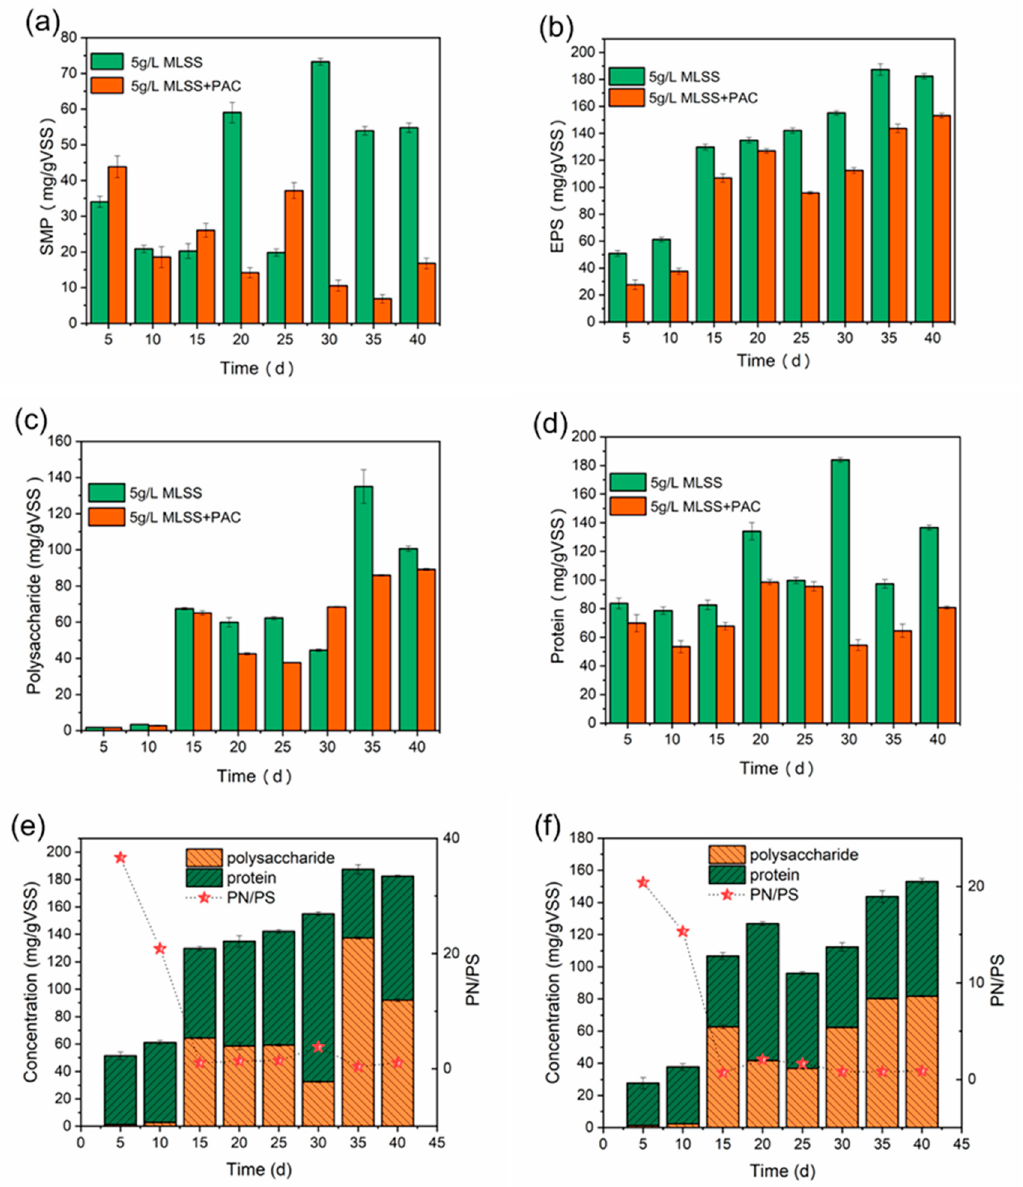
Figure 6. Contents and composition of ( a ) SMP, ( b ) EPS, ( c ) polysaccharide, ( d ) protein in sludge cake layer and ( e , f ) the proportion of polysaccharides and proteins in EPS of the sludge.